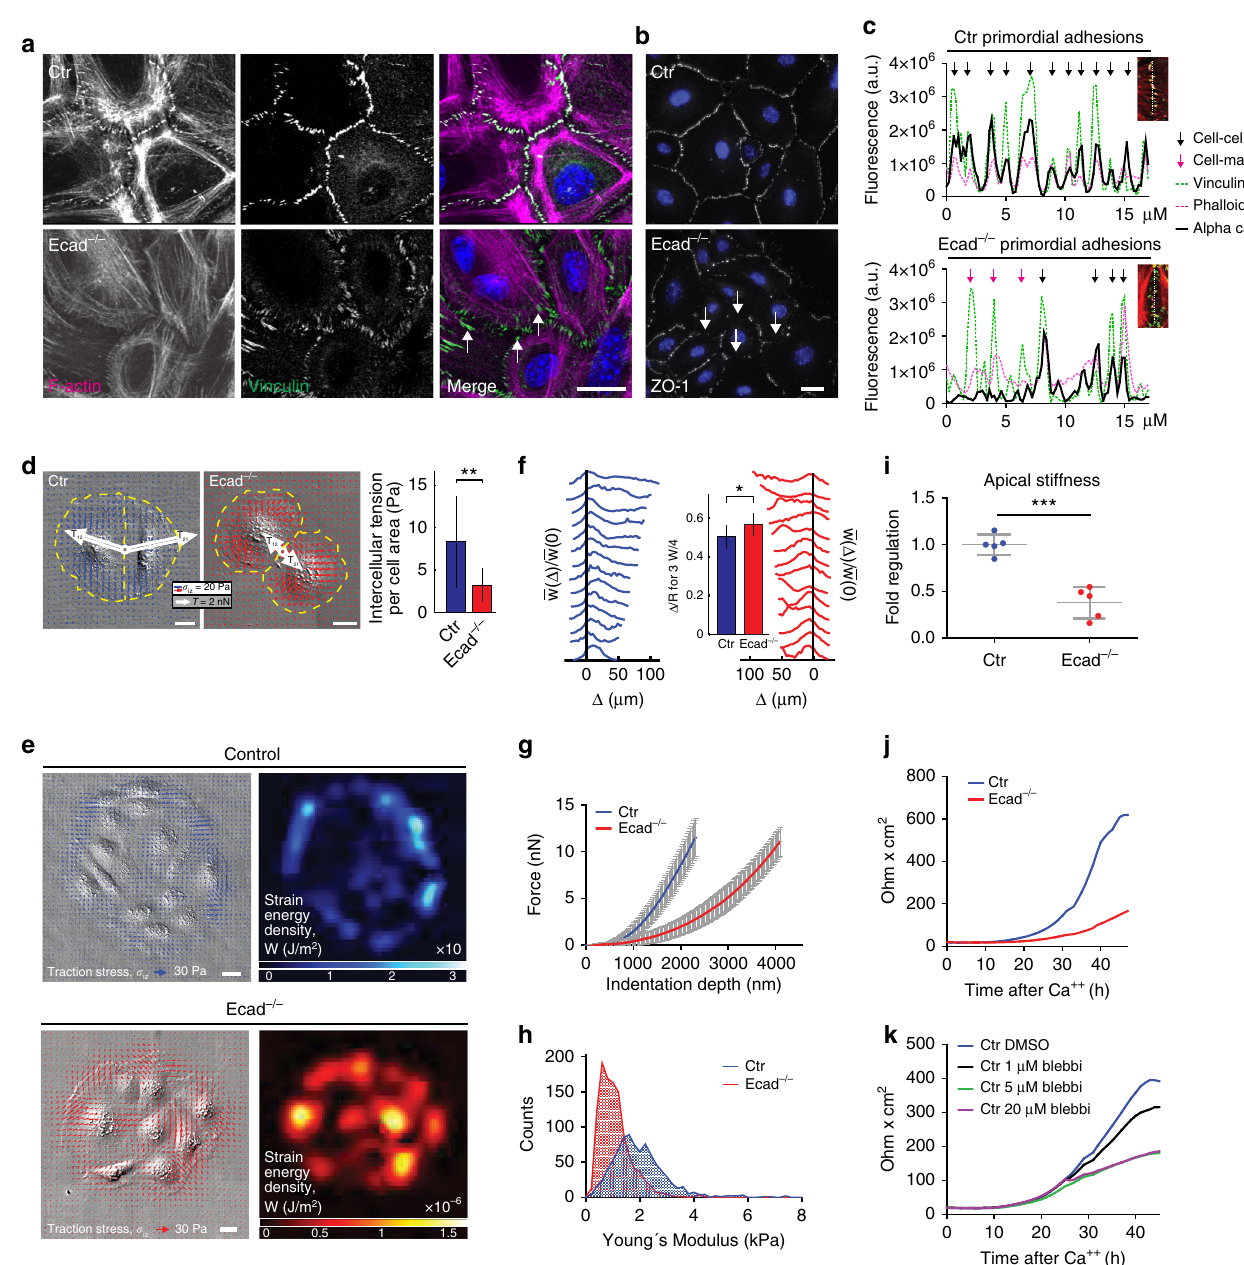
Fig. 5 E-cadherin controls AJ zipper formation and intercellular tension. a Immuno fl uorescence analysis for vinculin and F-actin and b ZO-1 in keratinocytes 2 h in high Ca 2+ . White arrows indicate cell – matrix contacts a and irregular zipper formation b . c Line plot pro fi le of cell contacts, pink arrows: cell – matrix contacts, black arrows: cell – cell contacts. a – c Representative images/pro fi les of n ≥ 3 biological replicates. d Traction force microscopy. (Left) Distributions of in-plane traction stresses (blue and red arrows), σ iz , for pairs of control (Ctr) or E-cadherin (Ecad) − / − keratinocytes after 24 h in Ca 2+ , overlaid on DIC images. White arrows: resultant intercellular tension, T 12 , of cell 2 on cell 1, and vice versa, given by vector sum of in-plane tractions within dashed yellow boundary of opposite cell of the pair. (Right) Quanti fi cation of intercellular tensions per cell area for Ctr ( n = 14) or Ecad − / − ( n = 15) keratinocyte pairs. Error bars: standard deviations. ** P = 0.002, Student ’ s t -test. e In-plane traction stresses (blue and red arrows) overlaid on DIC images and strain energy densities (blue and red heat maps) of Ctr and Ecad − / − keratinocyte colonies 24 h in high Ca 2+ . f Line plots of normalized strain energy distributions from edge ( Δ = 0) to colony interior for Ctr (blue, n = 14) and Ecad − / − (red, n = 14) colonies. f Graph represents fraction of inward displacement from colony edge needed to capture 3/4 of total strain energy. Error bars: standard deviations. * P = 0.0102, Student ’ s t -test. Scale bars, 20 μ m. g AFM force indentation plots, mean plots of n = 8 representative measurements including 2 primary Ctr and E-cad − / − cell lines after 48 h in high Ca 2+ are shown. h Distribution of Young ’ s moduli from a representative indentation experiment on 2 primary Ctr and E-cad − / − cell lines 48 h in high Ca 2+ (Ctr: n = 853, E-cad − / − : n = 1099). i Relative Young ’ s moduli in Ctr and E-cad − / − cells. Median values of biological replicates were used for statistical analysis. *** P = 0.0001; Ctr/Ecad − / − n = 5 biological replicates with Student ’ s t -test ( > 300 measurements/replicate). j Transepithelial resistance (TER) measurements in Ctr and Ecad − / − keratinocytes. Representative example of n > 10 independent isolates. k TER measurements in primary keratinocytes upon Blebbistatin treatment 24 h after switching to high Ca 2+ . Scale bars, 20 µ